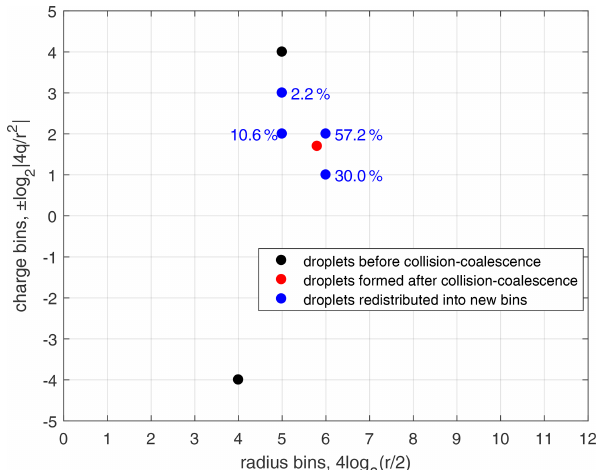
Figure 4. An example of droplet redistribution to new size and charge bins after collision–coalescence. Black dots denote the two bins of droplets before collision–coalescence. The red dot denotes the droplets after collision–coalescence but not on the bin grids. Blue dots denote the droplets that are redistributed to the new bins. Numbers close to the blue dots are the percentage of droplets that are redistributed into that bin. The redistribution method is con- strained by particle number conservation, mass conservation, and charge